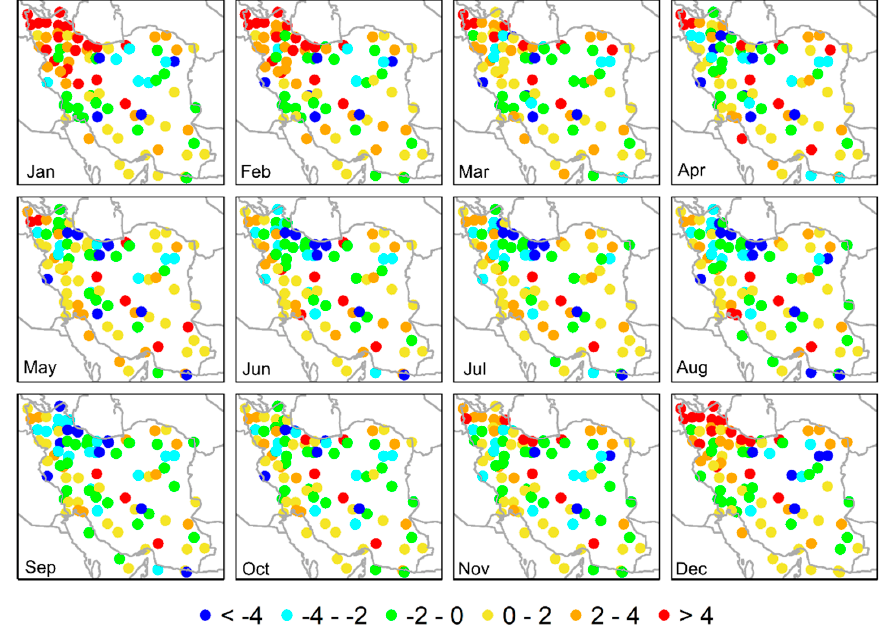
Figure 4. Deltas (°C) between monthly Princeton and observed monthly maximum temperature from 1988 to 2012.